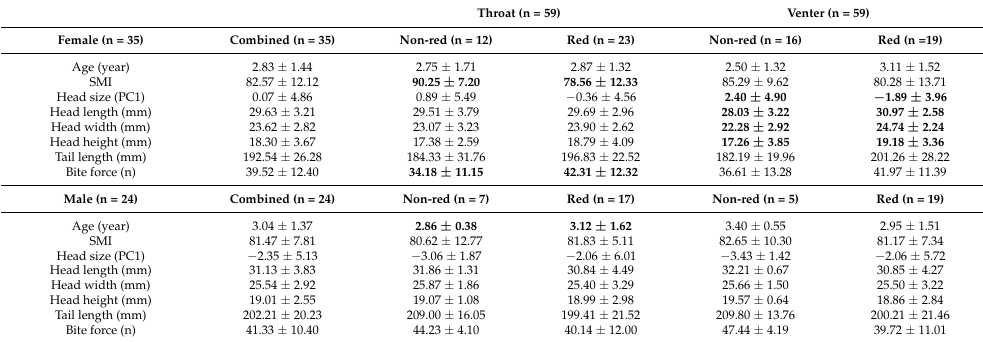
Table 2. Summary of means and standard deviations of phenotypic traits for two colour variants (non-red, red) for each body region and sex. PC1 of head size explained 86% of the total variation in head length, width and height, and PC1 was negatively correlated with head length, width and height. Bold indicates significant difference ( p < 0.05) between two colour variants.